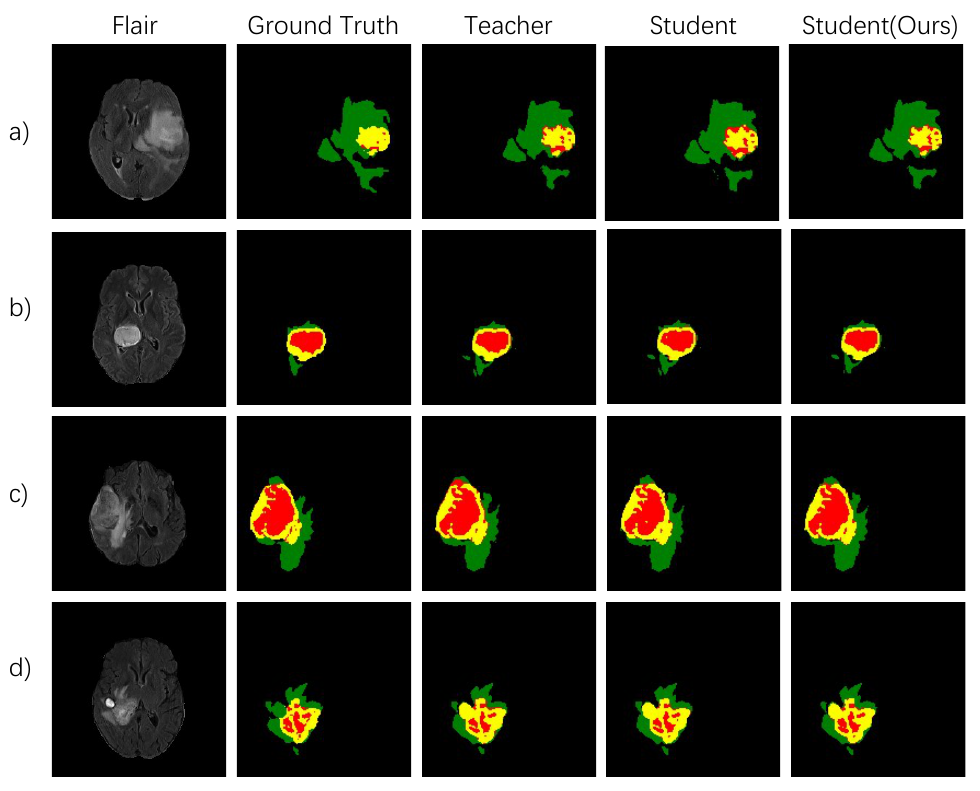
Figure 2. The segmentation results were obtained by applying our distillation method in four cases ( a – d ) of the BraTS validation dataset. ET—yellow, TC—yellow+red, WT—yellow+red+green. The teacher was UNet and the student was